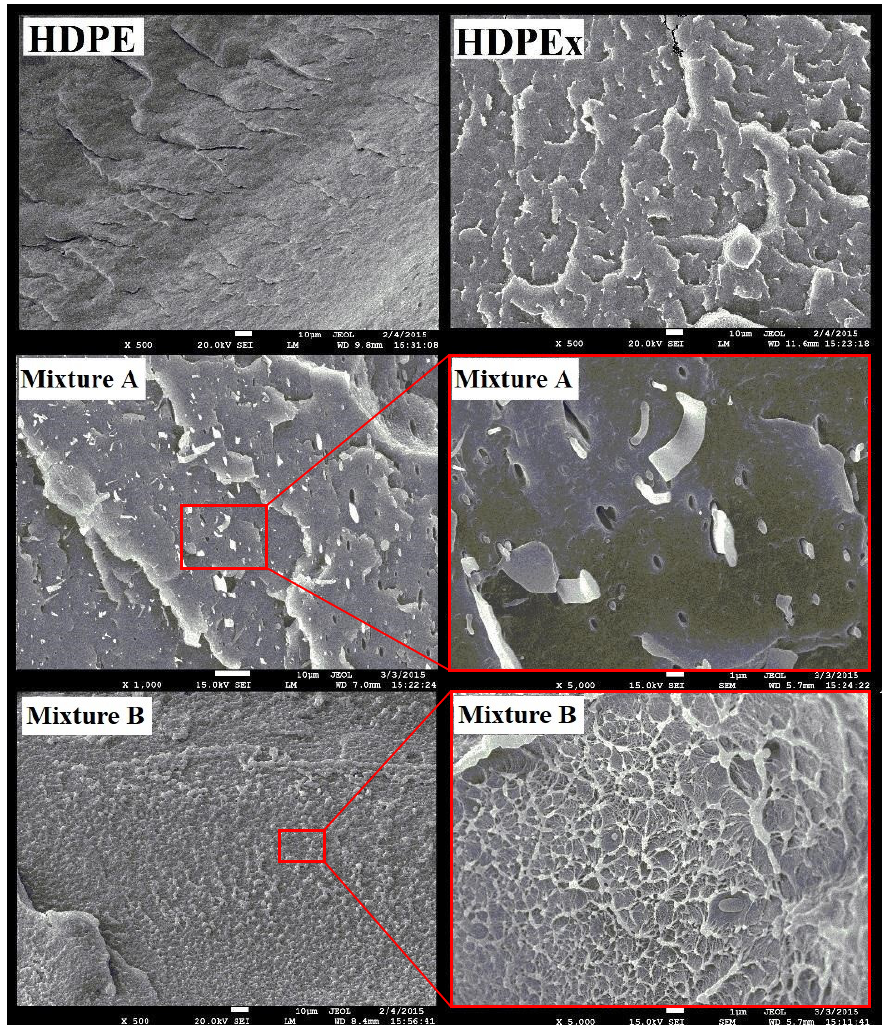
Figure 10. SEM—fracture surface